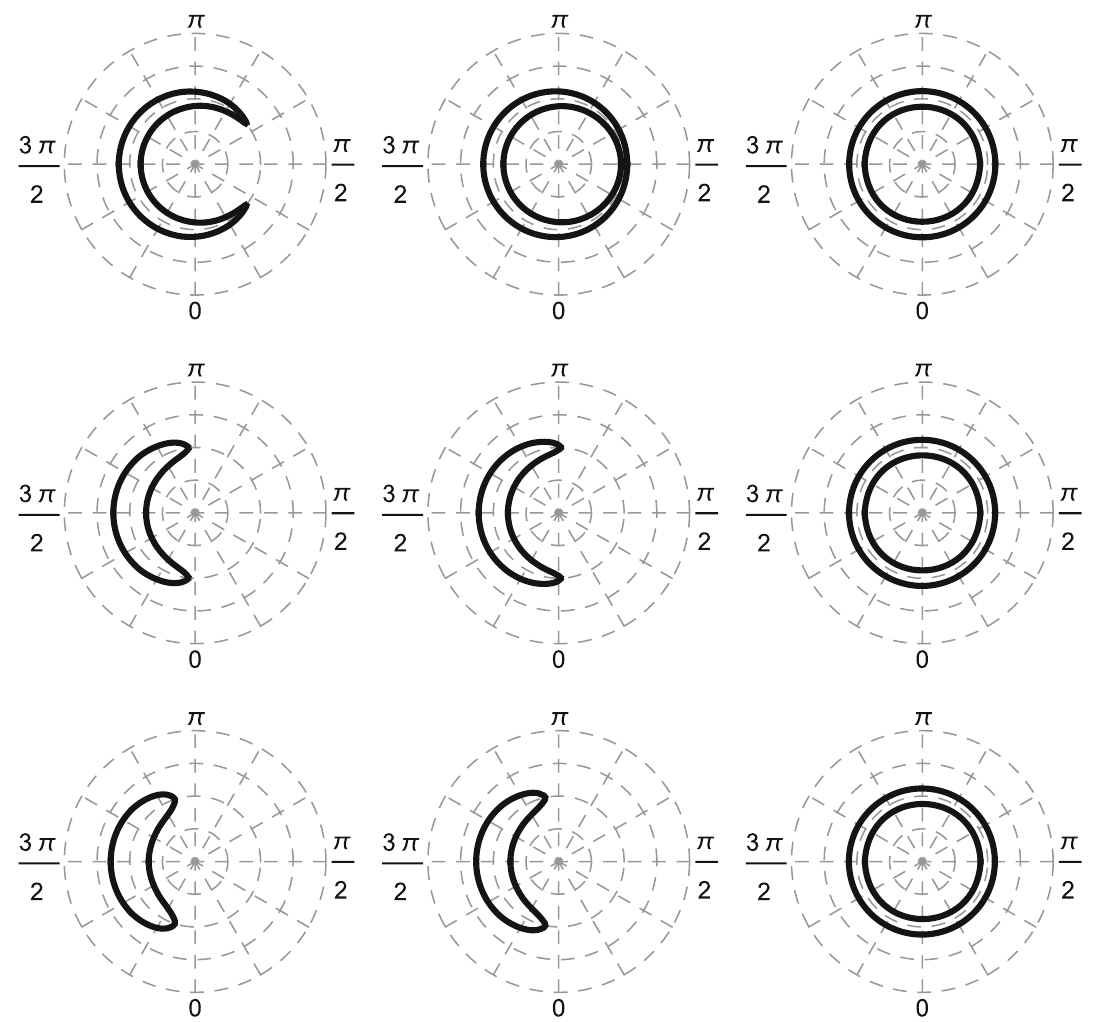
Fig. 12 Escape cones for objects with compactness R / M = 2 . 8 for several values of θ and j . The first column is for θ = π/ 2, the second column is for θ = π/ 4 and the last column is for θ = 1 / 100. The first row is for j = 0 . 1, the second row is for j = 0 . 4 and the last row is for j = 0 .